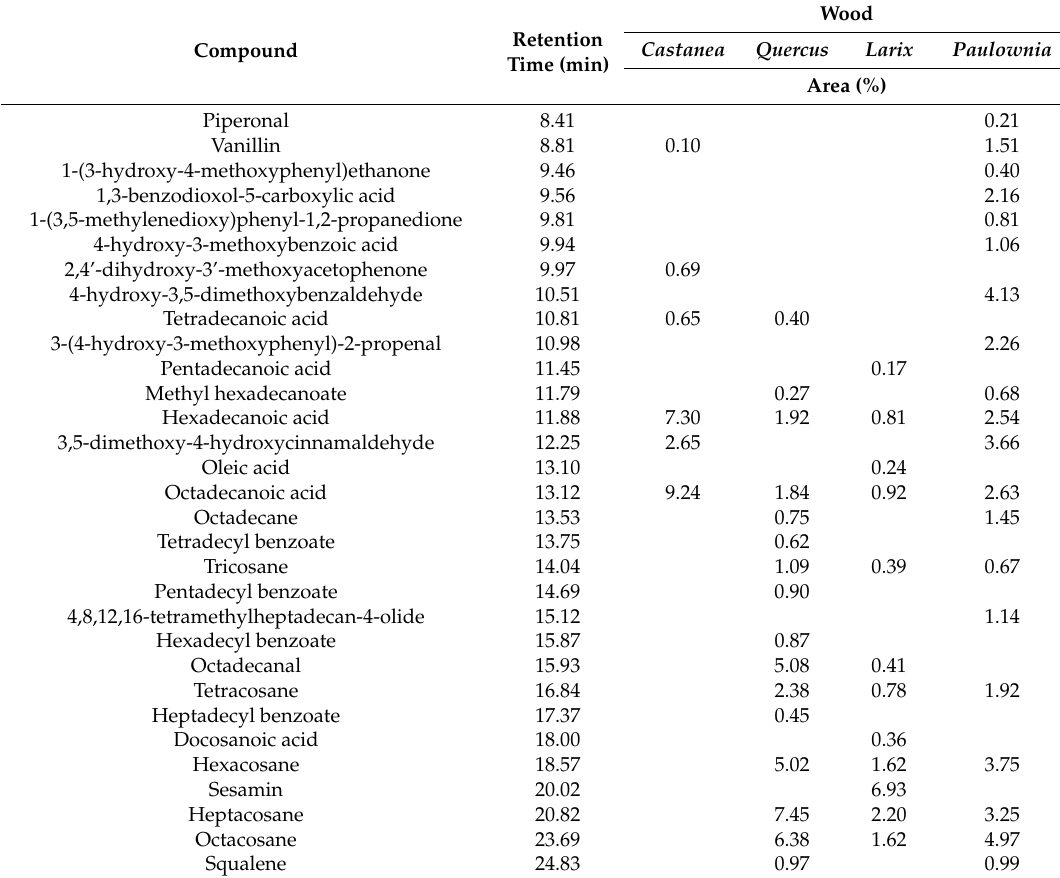
Table 5. GC-MS analysis of chloroform soluble water extractives in the presence of H 3 PMo 12 O 40